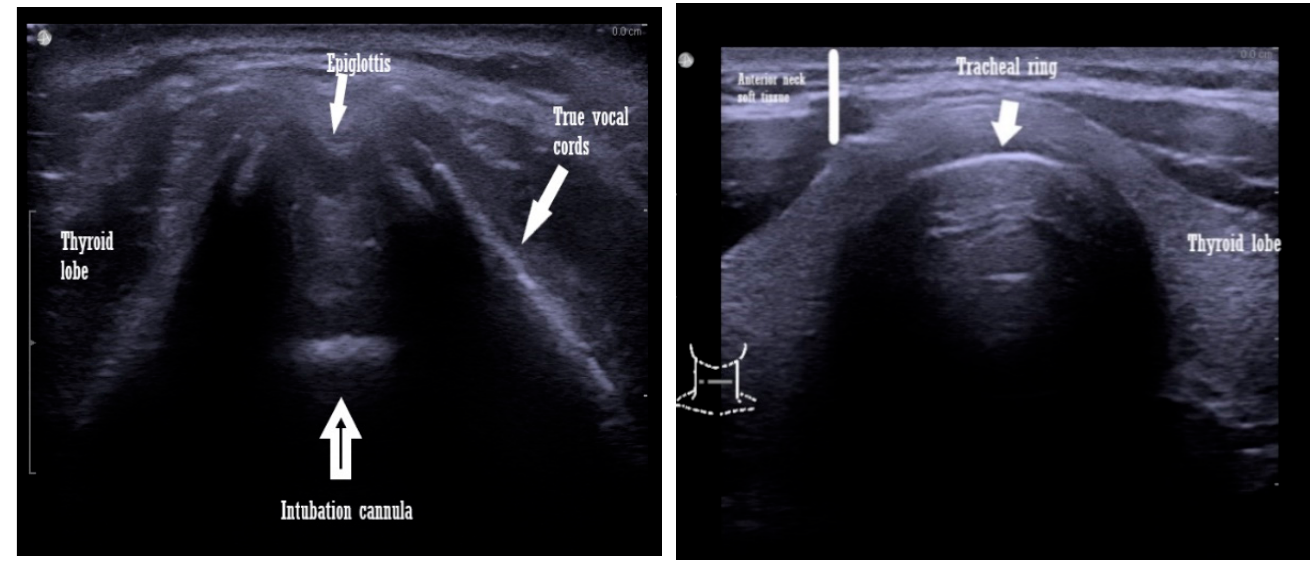
Scheme 1. Transcutaneous view with a linear ultrasound probe of an intubated patient airway ( left image) and a non intubated patient ( right